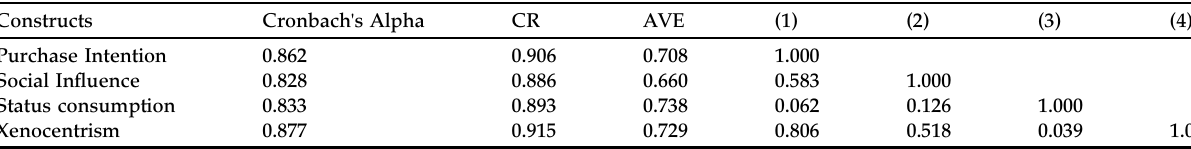
Table 1. Reliability, convergent and discriminant validity.